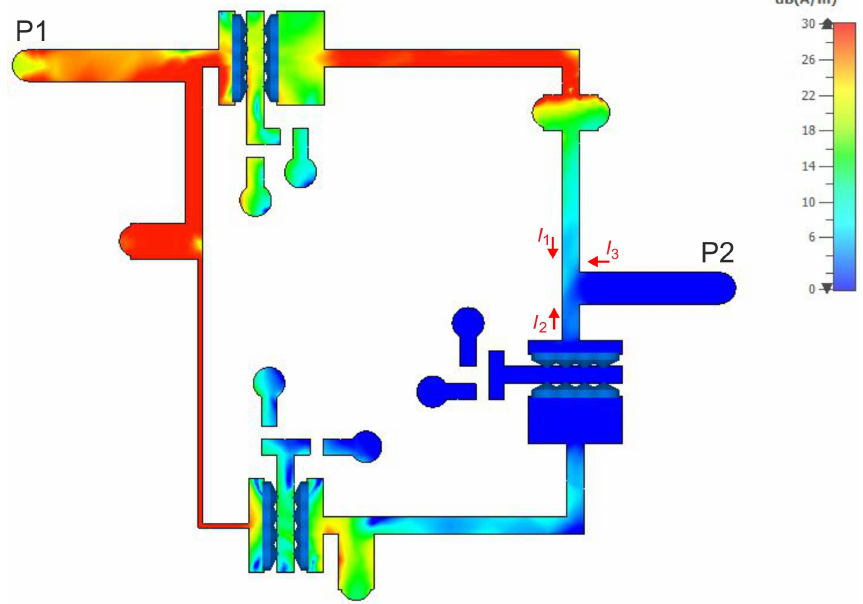
Figure 18. Current density distribution at the lower TZ frequency (490